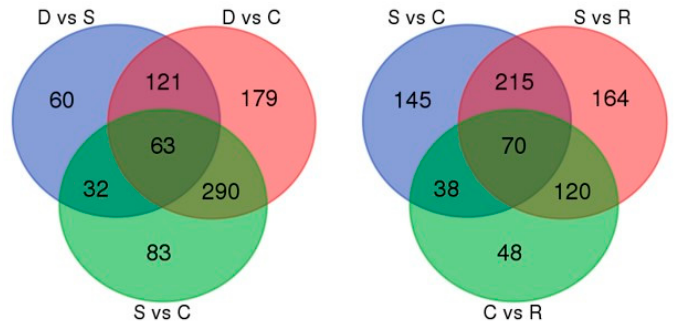
Figure 6. Venn diagram showing the numbers of differentially abundant proteins (DAPs) in various comparative groups.